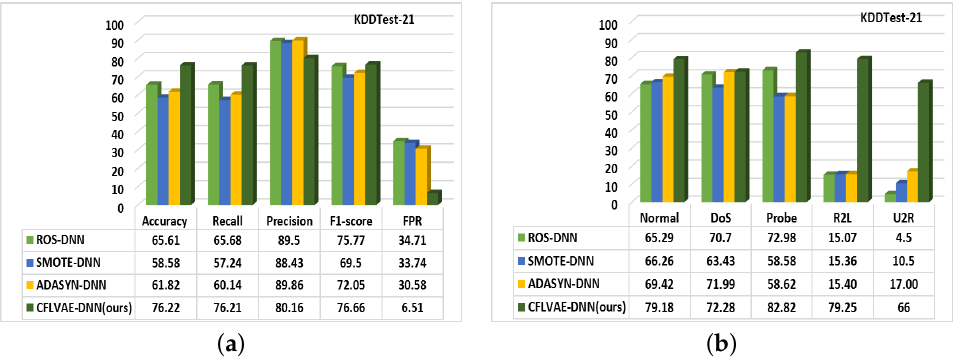
Figure 11. Comparison of ( a ) Overall detection rates and ( b ) Class-wise detection performance of data generation techniques on the KDDTest-21 dataset (in